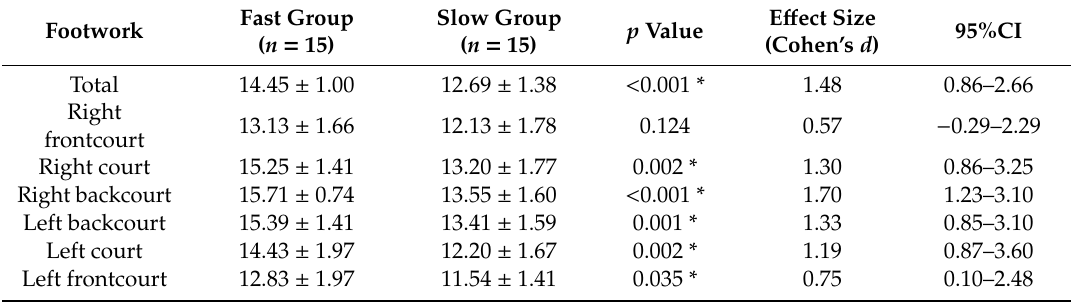
Table 2. Mean acceleration (m/s 2 ) for the entire footwork task and in each direction for the fast and slow groups. Mean ± standard deviation.